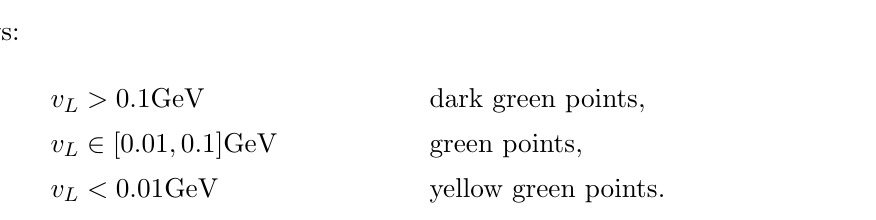
Figure 3 . (cid:11) 2 and (cid:11) 3 versus (cid:11) 1 . The color code is as in (cid:12)gure 2. See text for the